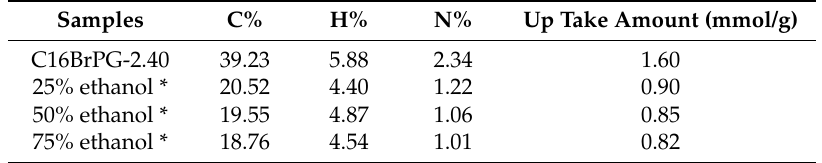
Table 2. C, H, N analysis of C16BrPG-2.40 after washing with different mixtures of ethanol and water.